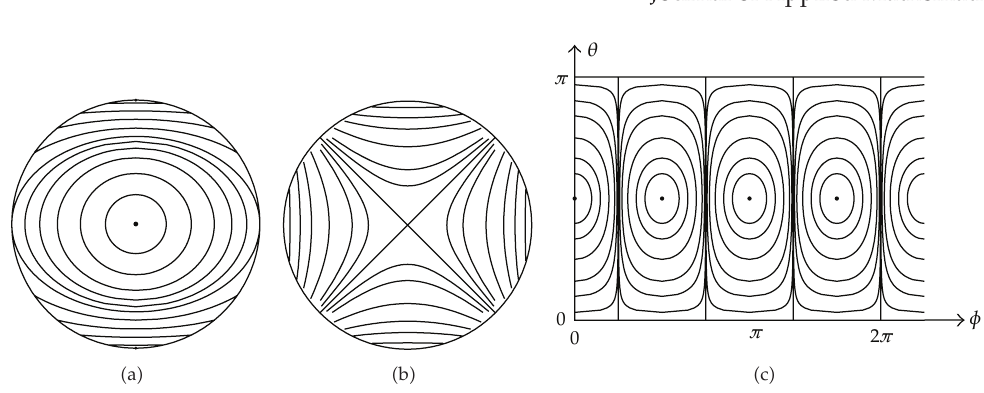
Figure 3: Counterrotating point vortices on a sphere with m (cid:7) 2 viewed from (cid:5) a (cid:6) positive y -axis; (cid:5) b (cid:6) positive z -axis; (cid:5) c (cid:6) in φ - θ